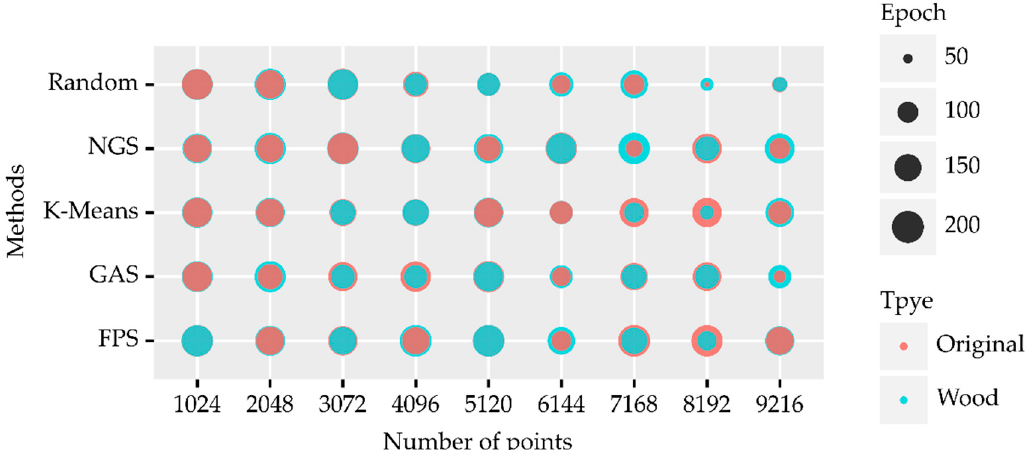
Figure 12. Epoch count for deep learning models to obtain optimal convergence parameters.